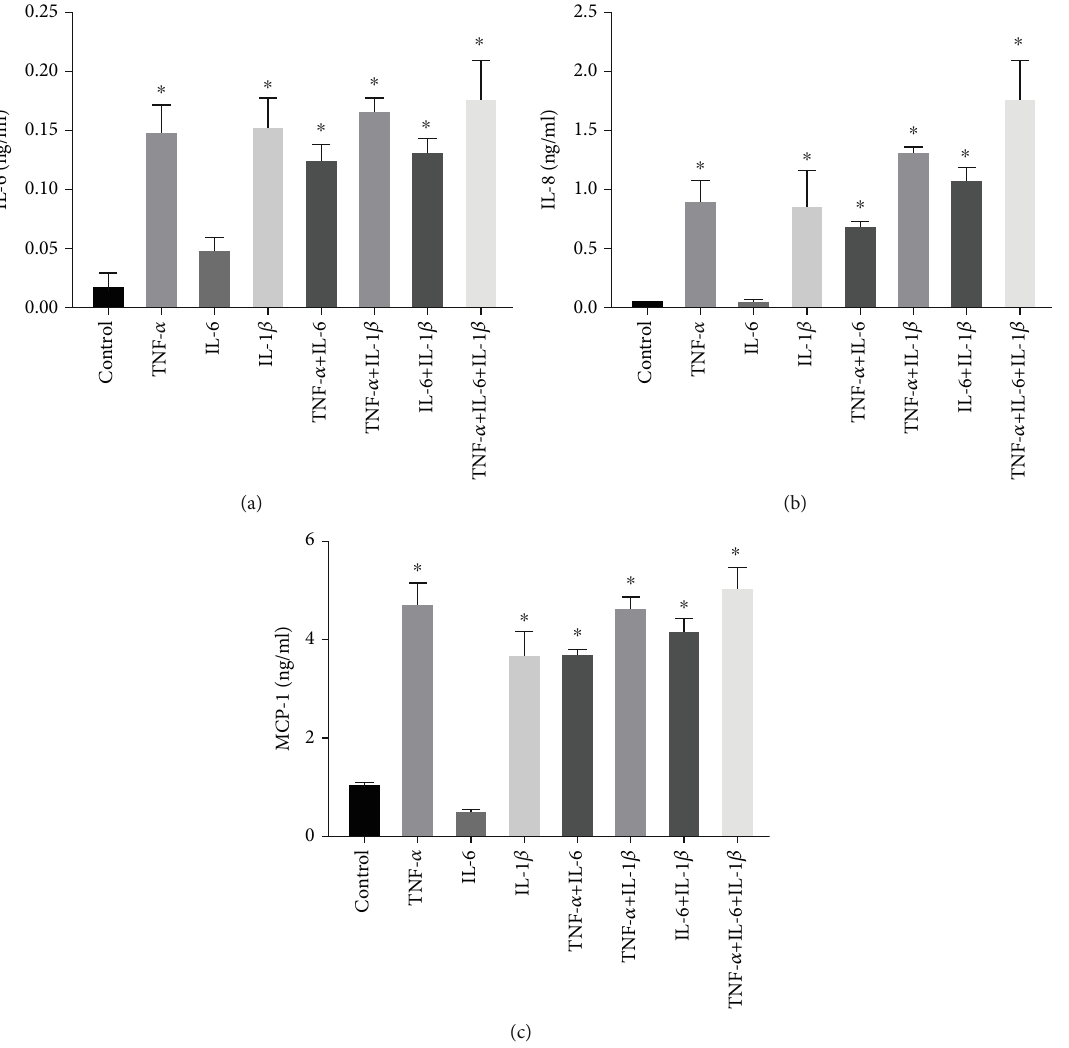
Figure 3: Cytokine-induced proin fl ammatory gene expression in ARPE-19 cells. The levels of (a) IL-6, (b) IL-8, and (c) MCP-1 in ARPE-19 cells were measured using the ELISA Ready-Set-Go kit. TNF- α +IL-6+IL-1 β treatment signi fi cantly increased the levels of IL-6, IL-8, and MCP-1. The data are expressed as mean ± SD of three independent experiments. ∗ p < 0 : 05 compared with the control